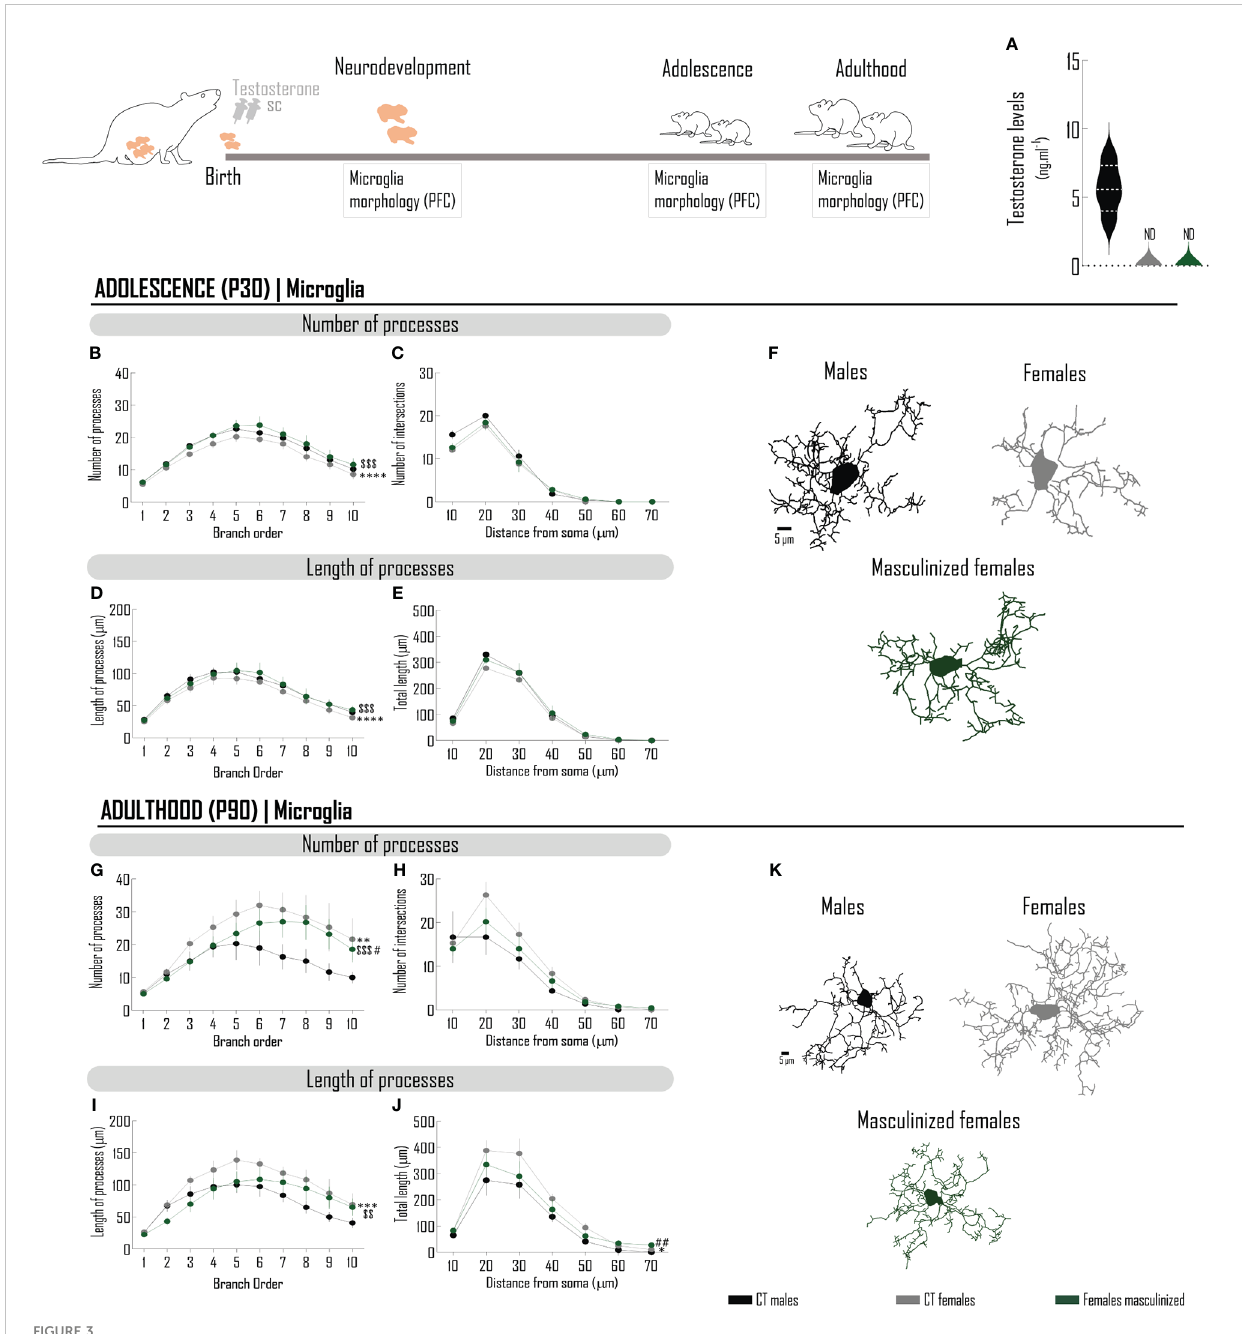
FIGURE 3 The acute administration of testosterone to newborn females masculinizes microglia morphology in the PFC. Schematic drawing of the pharmacological treatment: female Wistar rats were injected with testosterone (100 µg/25 µL, sc) at PND0. (A) Endogenous testosterone levels quanti fi ed by ELISA measured at PND90. Microglia was stained with Iba-1 and 3D manual reconstructions were performed using Neurolucida Software. Different morphometric parameters were extracted at adolescence (PND30) (B – F) and adulthood (PND90) (G – K) : number and length of microglial processes per branch order (B, D, G, I) and sholl analysis (C, E, H, J) . Representative microglia projections from each age are depicted in (F, K) . Results are presented as mean ± SEM. * p <0.05 comparing CT males (black circles) and females (gray circles). # p <0.05 comparing CT males and females masculinized (green circles); $ p <0.05, comparing CT females and females masculinized. PFC, prefrontal cortex; SC,